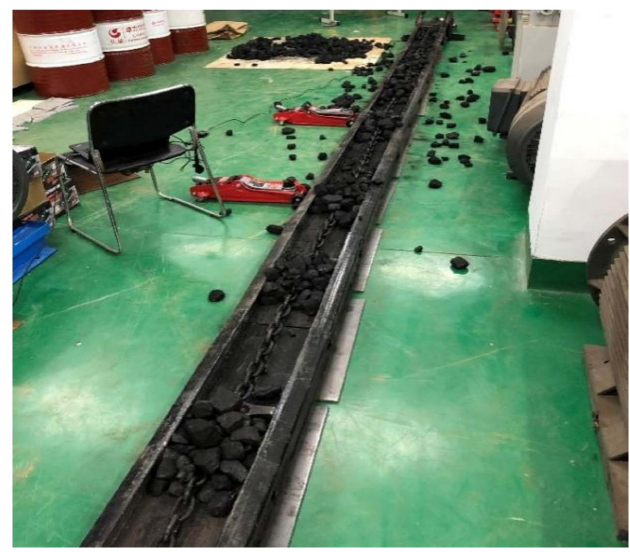
Figure 3. Loaded condition of the test bench.